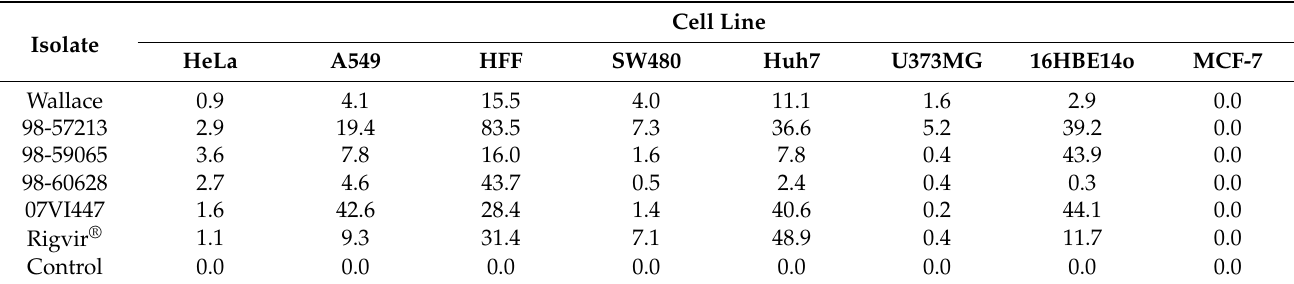
Table 3. Infection efficiency based on quantitative image analysis of the immunofluorescence images. Infection efficiency is represented as a percentage of total number of cells in each image infected by the respective virus isolate.